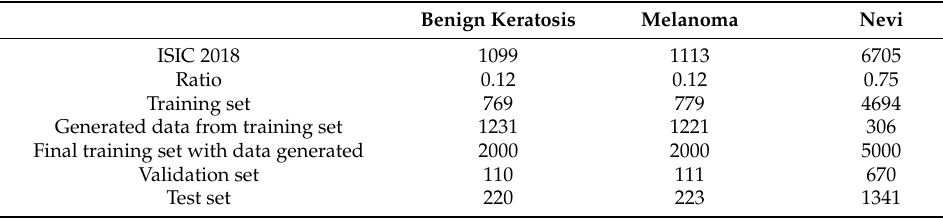
Table 4. Distribution of the